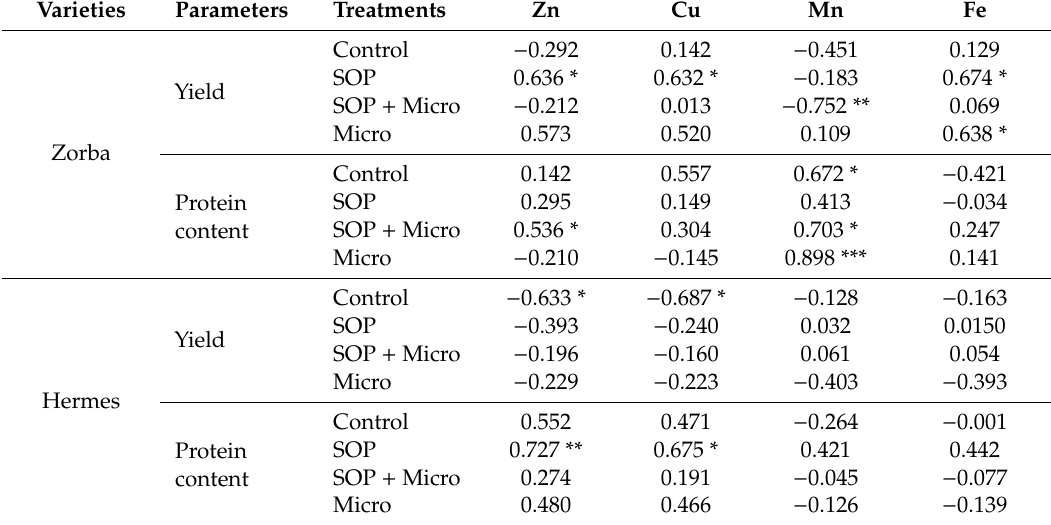
Table 1. Correlation analysis for the relationships between tuber yield, protein and micronutrient contents in potato tubers.